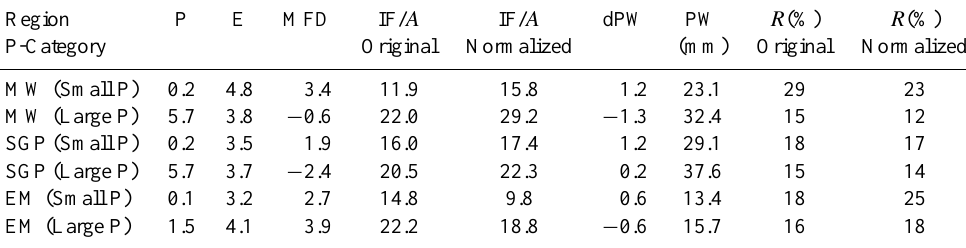
Table 2. Mean WVB components and R values for the MW, SGP, and EM regions delineated in Fig. 1a and b. Symbols are as in the text. IF/ A and R values are presented in original and normalized forms (see Sect. 2.3). Normalized R values were computed using Eq. (4) with normalized IF/ A values given by Eq. (7). Small P in the MW and SGP refers to P ≤ 0.6mmd − 1 , and large P there is for 4 < P ≤ 8mmd − 1 . For the EM, these ranges are 0.01 ≤ P ≤ 0.15 and 0.9 ≤ P ≤ 2.2mmd − 1 , respectively. Units are mmd − 1 , except for PW (mm) and R (%). Region P E MFD IF/ A IF/ A dPW PW R (%) R (%) P-Category Original Normalized (mm) Original Normalized MW (Small P)